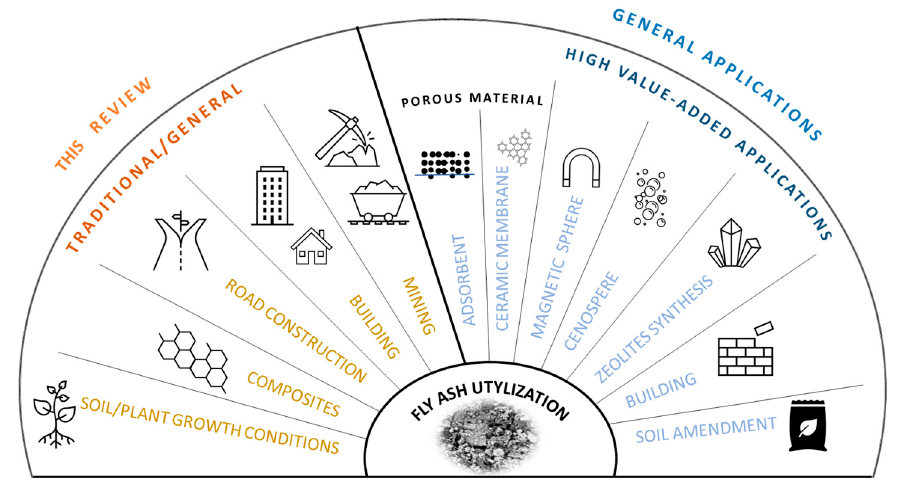
Figure 3. Fly ash utilization.